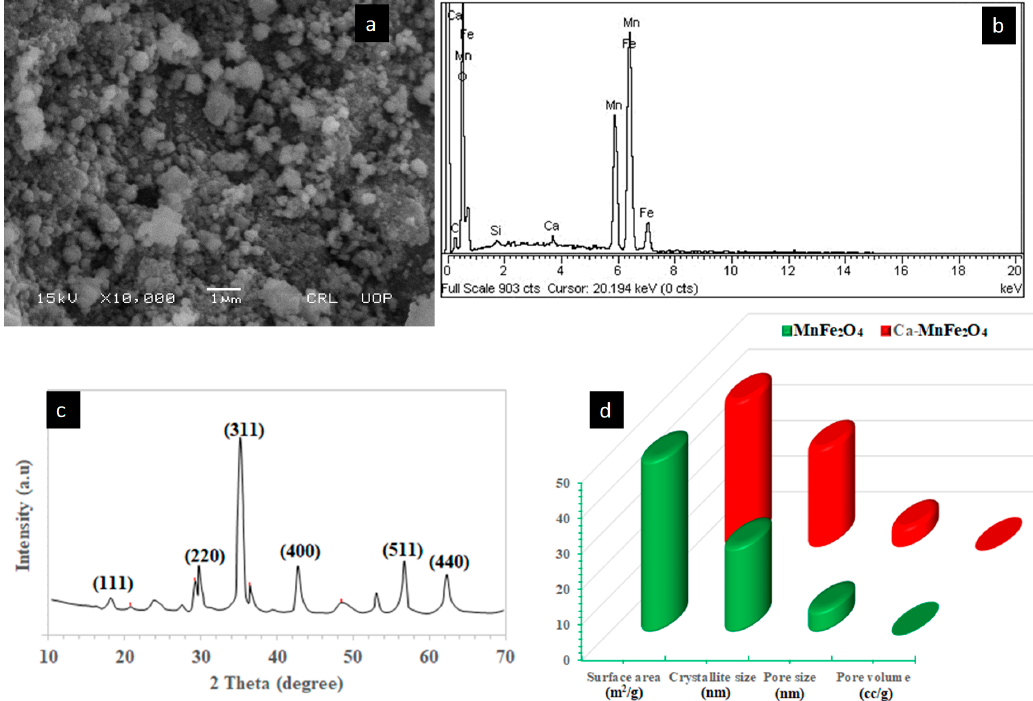
Figure 2. Physical characterization ( a ) SEM, ( b ) EDX, ( c ) XRD pattern of Ca-MnFe 2 O 4 , and ( d ) surface features of MnFe 2 O 4 and Ca-MnFe 2 O 4 .